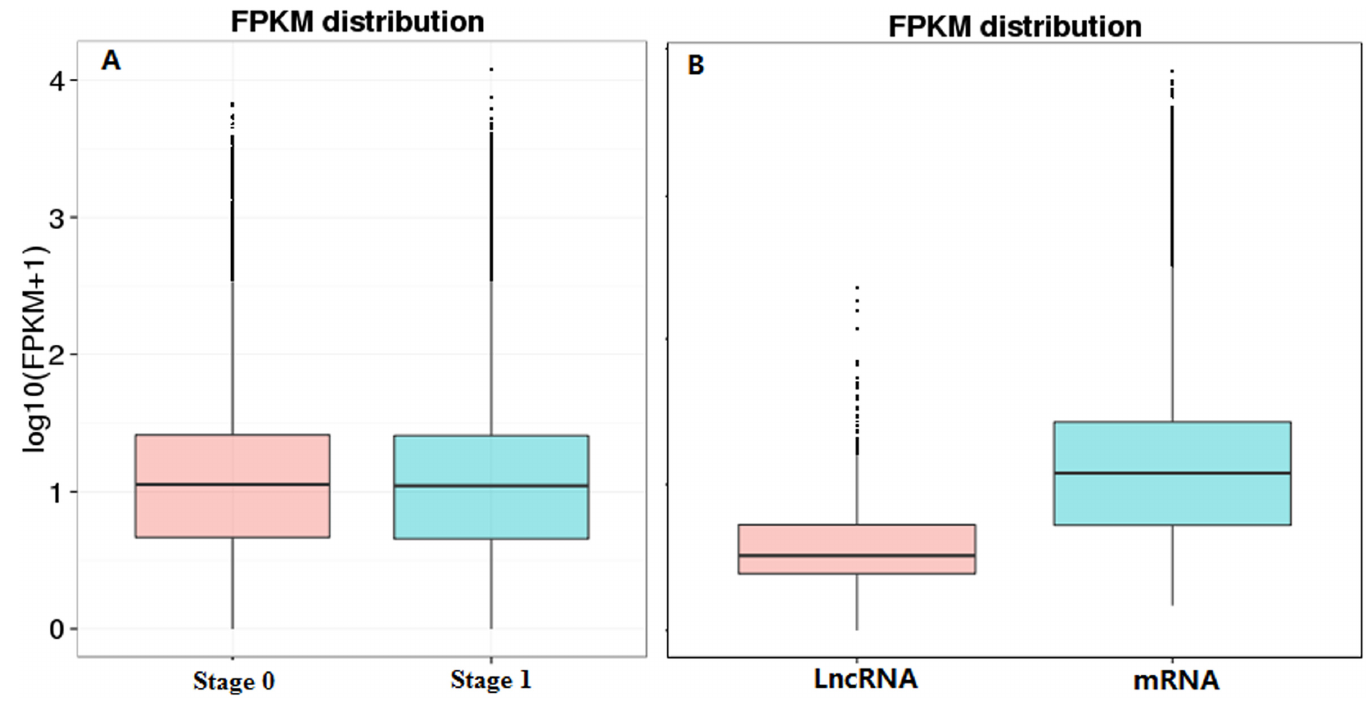
Fig 4. The FPKM distribution of mRNA and lncRNA expression in sheep skin during the initiation of secondary HF. (a) The FPKM density distribution of tanscript expression in sheep skin at stage 0 and stage 1.(b) the expression level of mRNA and lncRNA in sheep skin during the initiation of secondary